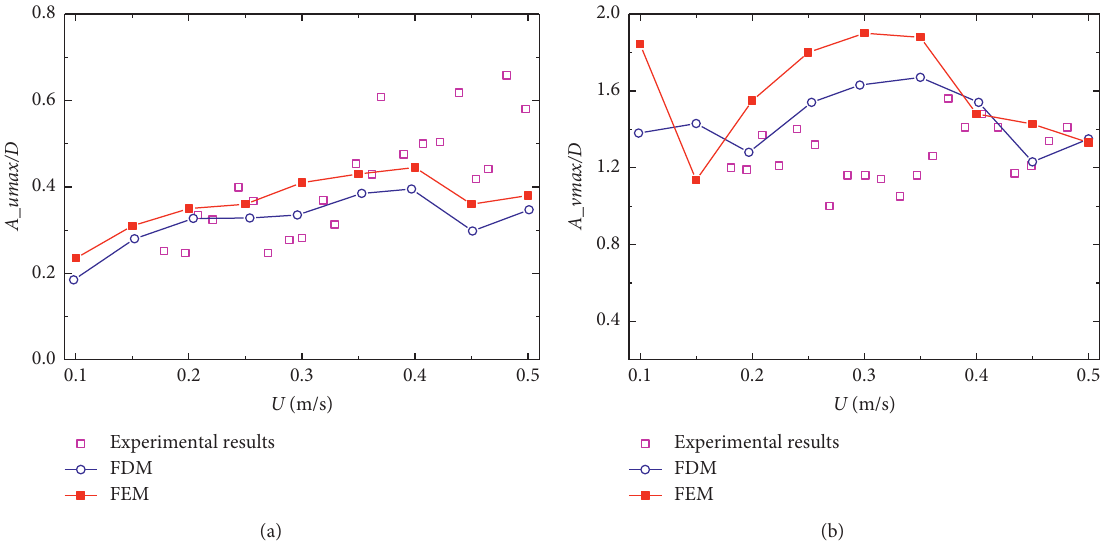
Figure 2: Comparison of maximum displacement amplitudes between the present results and value of experimental measurement of (a) in- line and (b)